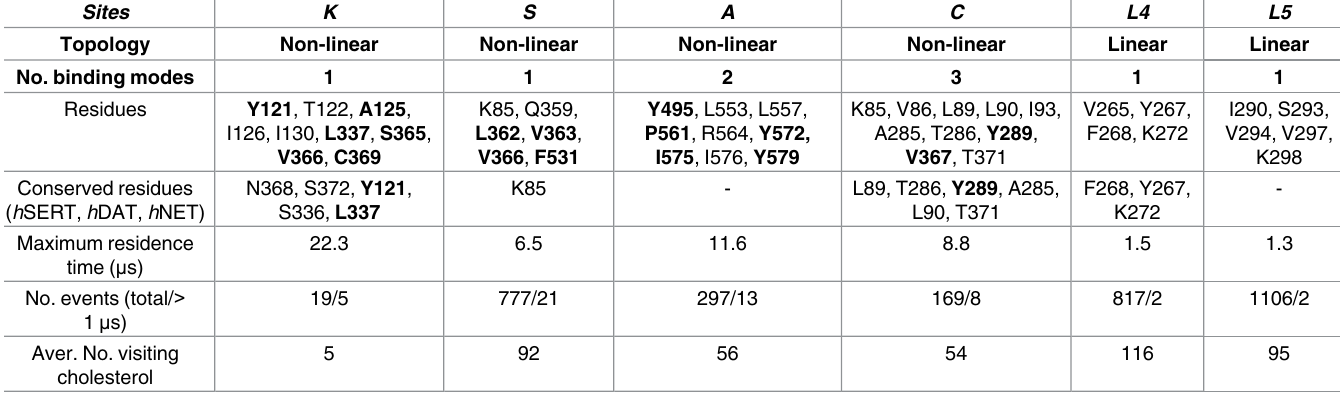
Table 3. Structural and dynamic featuresof sites. Outlier residuesconservedamong h SERT, h DAT, and h NET are shown in bold.